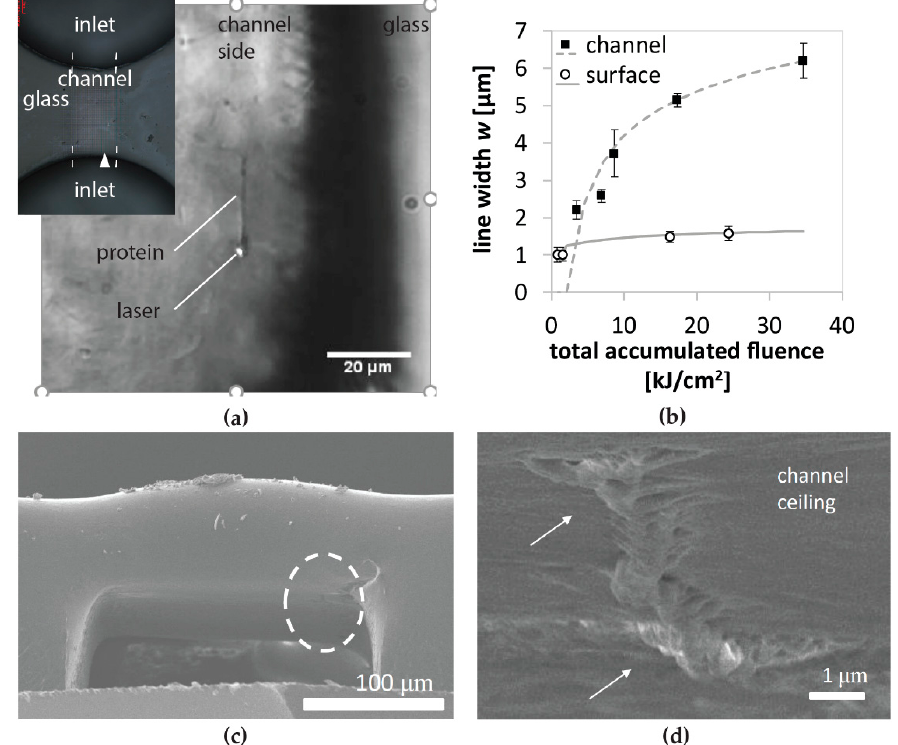
Figure 2. Bovine serum albumin (BSA) line pattern inside glass microchannel. ( a ) In situ CCD camera image of a BSA line pattern written with 0.79 mW and 5 μ m/s by a 200 kHz, 522 nm laser focused inside the glass channel. Inset shows an optical microscope image of the top view of the glass channel with two inlets, with an arrow indicating the position of the fabricated line and view direction in SEM observation. ( b ) Line width w vs. total accumulated fluence for line pattern on the glass surface as well as the inside of the glass channels. Solid and dashed lines indicate fitting based on a two-photon polymerization scheme with mean square deviations R 2 = 0.972 (surface) and R 2 = 0.987 (channel), respectively. These line widths were observed for laser powers of 0.0935–6.4 mW with scanning velocities of 0.2–10 μ m/s ( n = 3 for on-surface, n = 3 for in-channel fabrication). ( c ) SEM image in a tilted view inside the microchannel after cutting through the inlet. The point of view is indicated in ( a ), and a dashed ellipse highlights the area of magnification in ( d ). ( d ) SEM image inside the microchannel of the BSA line pattern, highlighted by arrows.